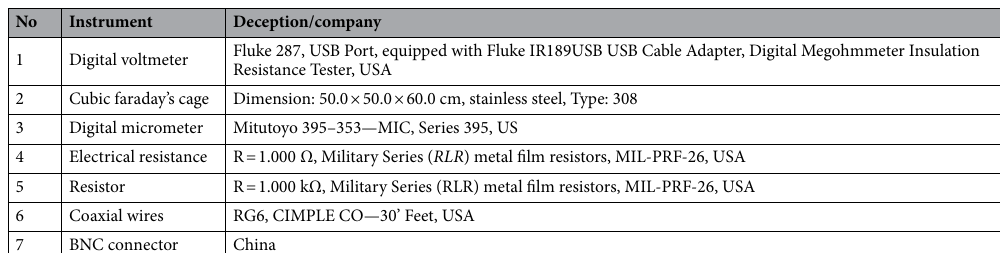
Table 1. List of adopted instrumentation system used for the comparative investigation between the cysts behavior at the VLF region. It was noticeable that, selection of electronic elements with the military series was based on dealing with electronic components with maximum reliability and minimum tolerance. In this system prior the analysis, all the modules of the instrumentation system were therefore calibrated and standardized using a serial resistance–capacitance (Serial R–C elements, military Series, 1.00 kΩ, ad 150.0 µF, Analog device) as dummy cell. For this purpose, the probes (wires) were directly connected to the R–C electronic circuit instead of the cysts body through the implanted electrode). At this condition, not only the researcher would access to full confidences about the accuracy of the electronic systems, but also, was able to calibrate all parts of the electronic modules such as the gain (sensitivity) of the amplifier and the average of the signal-to noise (S/N) ratio. The signal acquisition process was also adopted using the fluke tester through the USB port. Due to the effective role of the adopted and optimized VLF electrical signal on the cyst bio-analysis process, the experimental section about this waveform was evaluated with detail (Table 2). As clearly exhibited, the frequency range as well as the optimum values of the VLF wave were clearly reported. These factors were automatically provided via programming the assembled VLF function